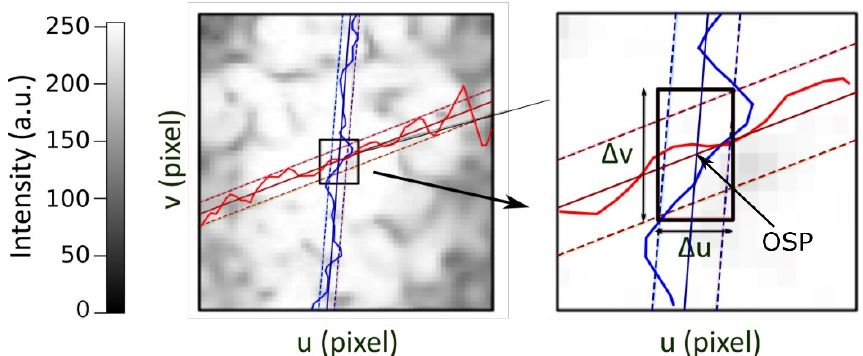
Figure 11. Example of a laser measurement of the spot center. Two different enlargements of the image of the laser spot are shown. The red line represents the points of maximum obtained fitting a section with u = constant, while the blue line shows points of maximum for v = constant. Mean values (straight lines) and standard deviations (dashed lines) are presented. The rectangle of uncertainty is shown in the largest enlargement.